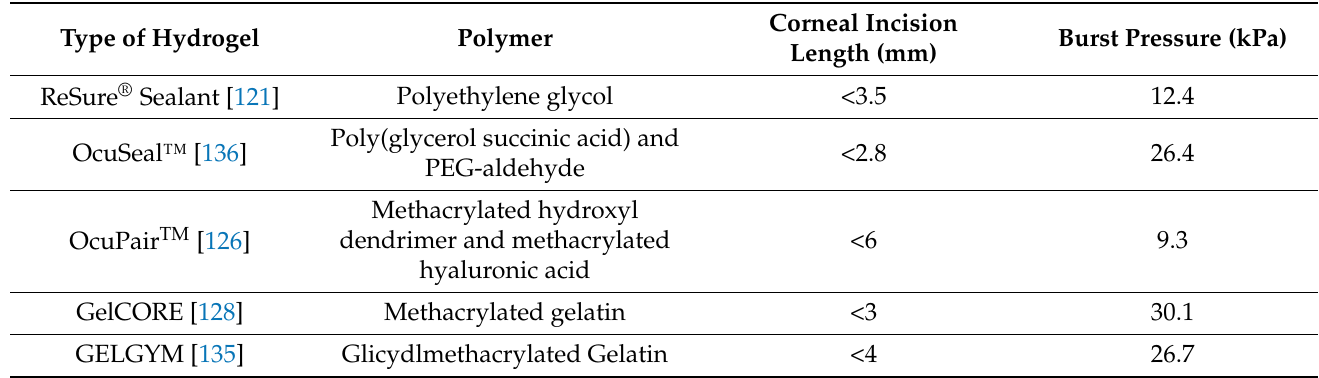
Table 3. Summary of hydrogels investigated as ocular